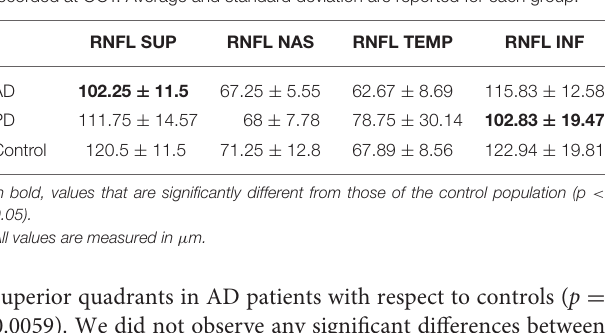
TABLE 2 | RNFL values for each quadrant (superior, nasal, inferior, temporal) recorded at OCT. Average and standard deviation are reported for each